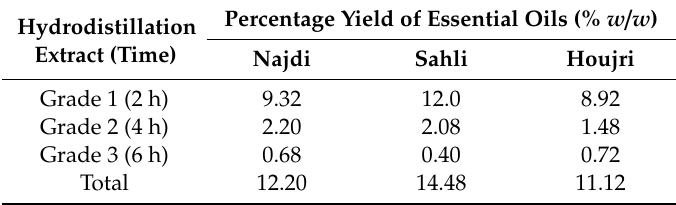
Table 1. Percentage yields of essential oils obtained from three di ff erent frankincense gum cultivars called Najdi, Sahli and Houjri, subjected to three successive hydrodistillations.